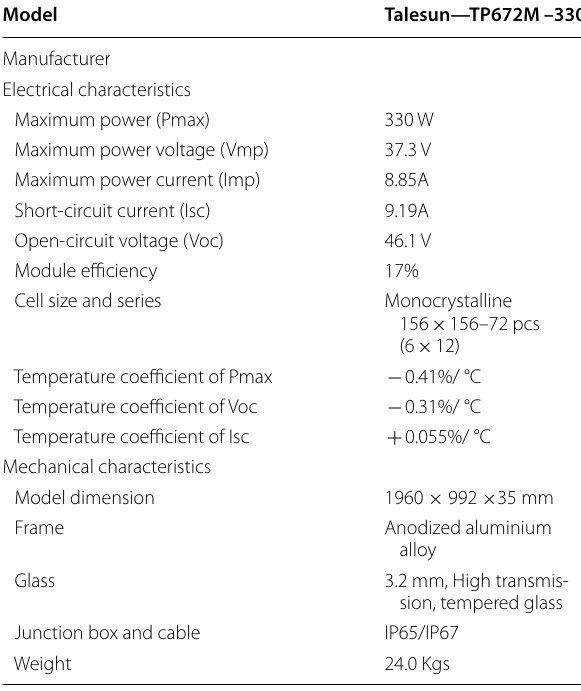
Table 4 The module specification of the proposed PV system for